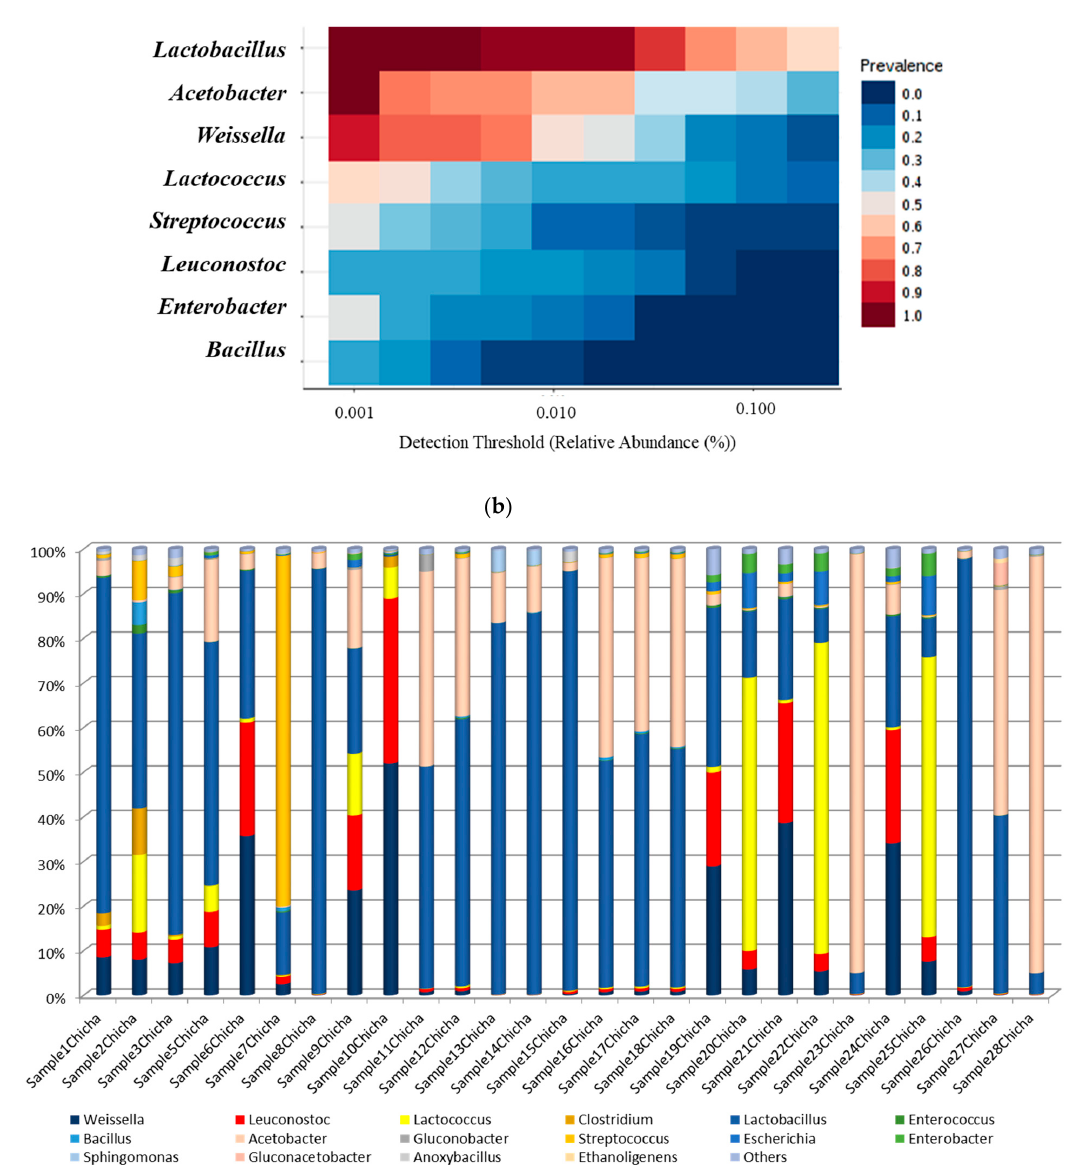
Figure 5. Core community ( a ) and distribution ( b ) at genus level of dominant bacteria colonizing chicha samples.